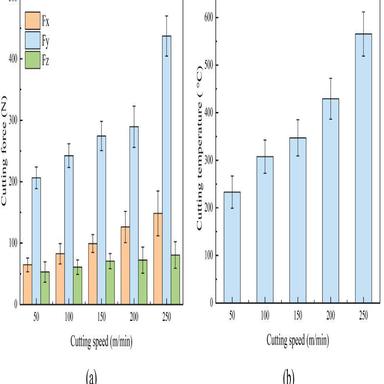
The cutting force (a) and cutting temperature (b) under different cutting speeds.